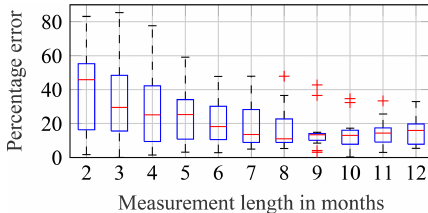
Figure 22. Convergence of the percentage error of predicted yearly damage values using simple extrapolation for increasing measure- ment lengths. Box plot shows data from 13 different measurement periods.